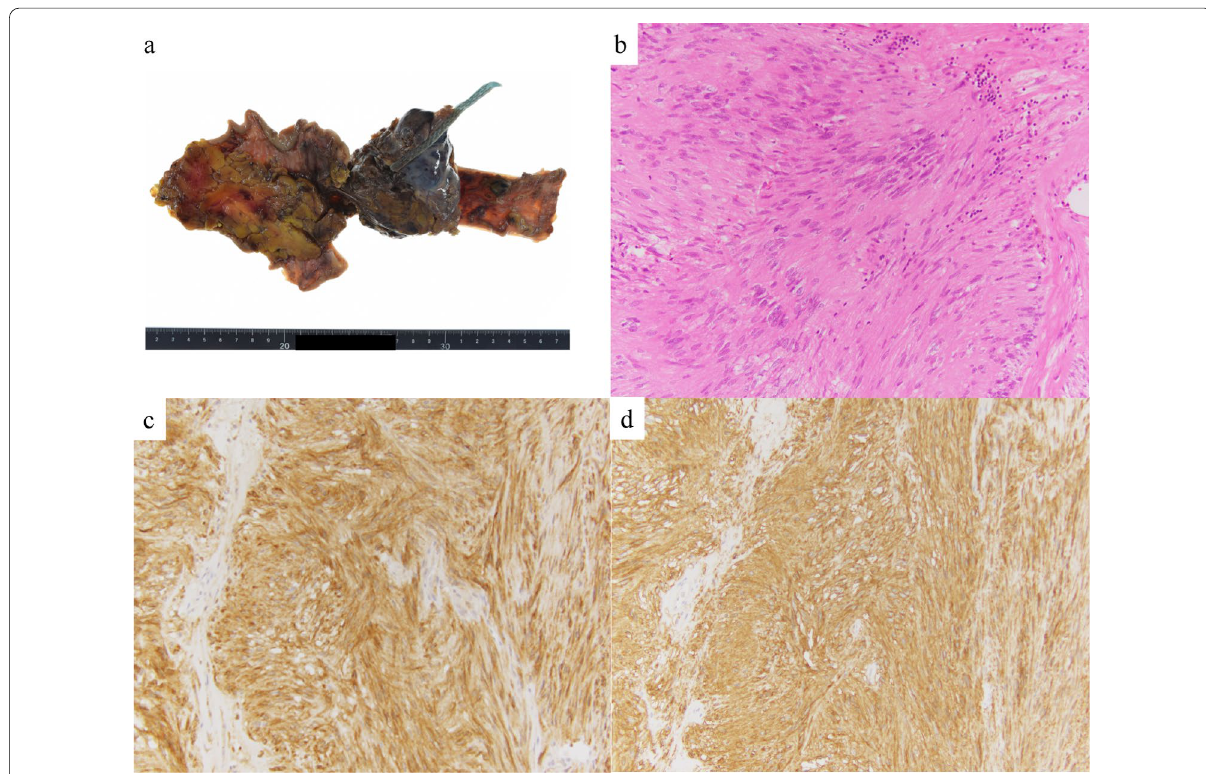
Fig. 4 Macroscopic observation of the resected specimen shows the tumor size to be 75 of the tumor cells show that spindle cells densely proliferate ( b ). Immunostaining of c-kit ( c ) and DOG-1 ( d ) shows diffuse dark-brownish deposition at the cytoplasm of the spindle tumor